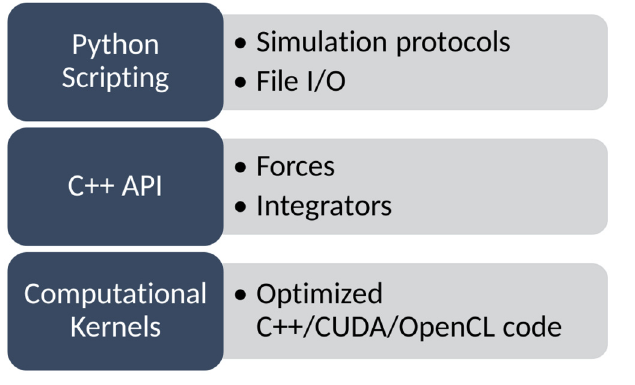
Fig 1. Architecture of